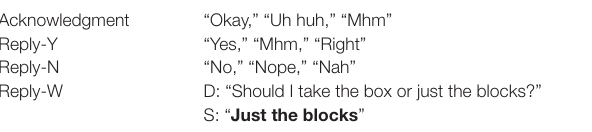
TaBle 2 | Response moves and